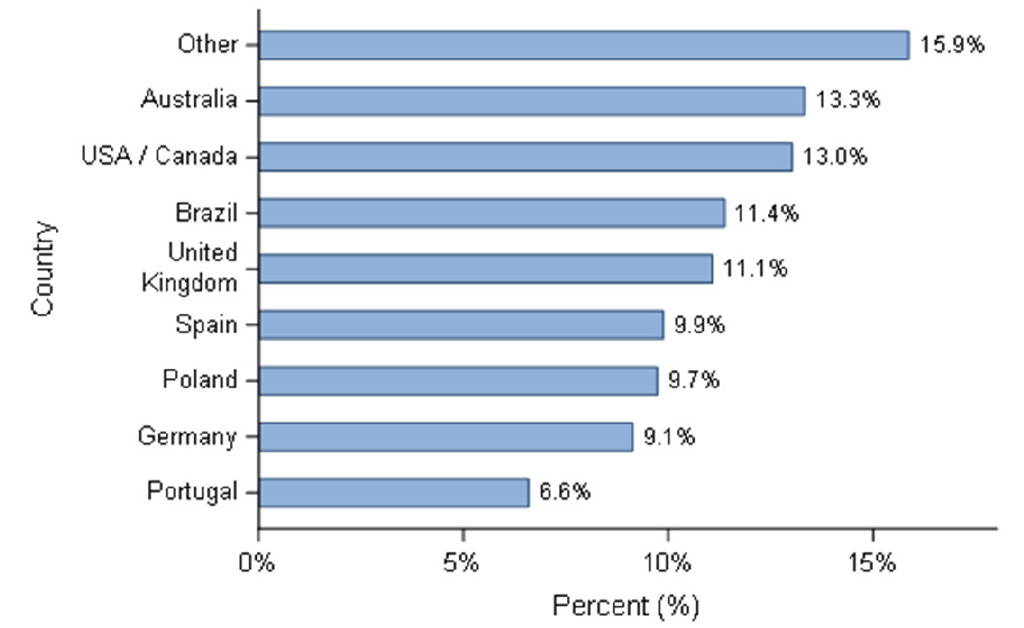
Figure 1. Responders’ distribution according to the country—all responders ( n = 668).